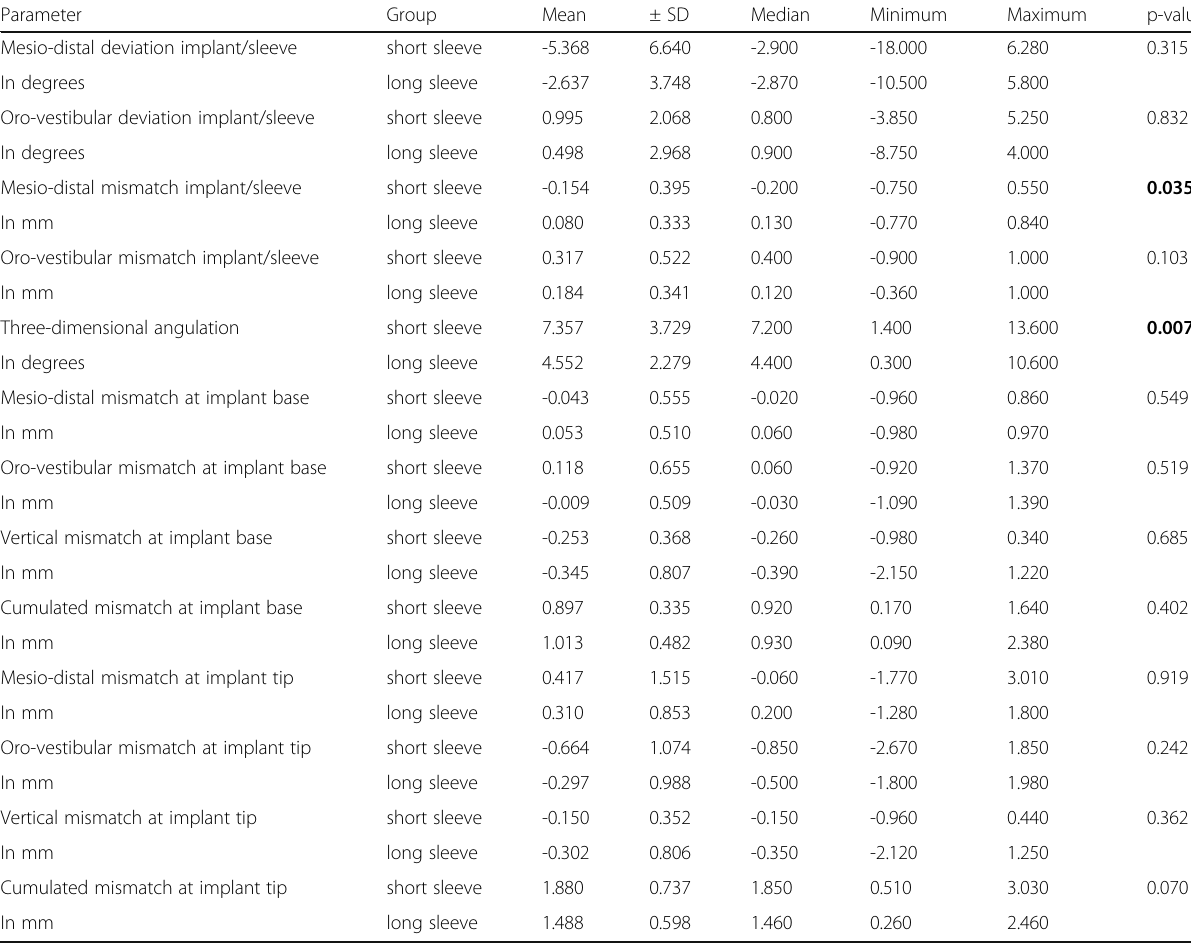
Table 3 Comparison of deviations and angulations between short sleeves (4 mm) and long sleeves (10 mm) for the pilot-drill guided implant insertion. The means, their standard deviations (SD), medians, minima and maxima are shown. The p-values are resulting from a pair-wise comparison. P-values for statistically significant differences are marked in bold font